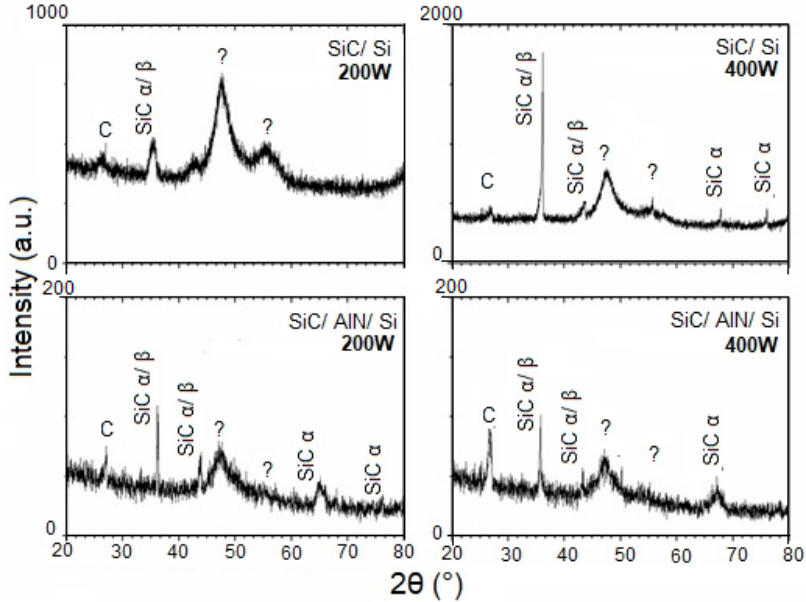
◦ . Micromachines 2019 , 10 , x FOR PEER REVIEW